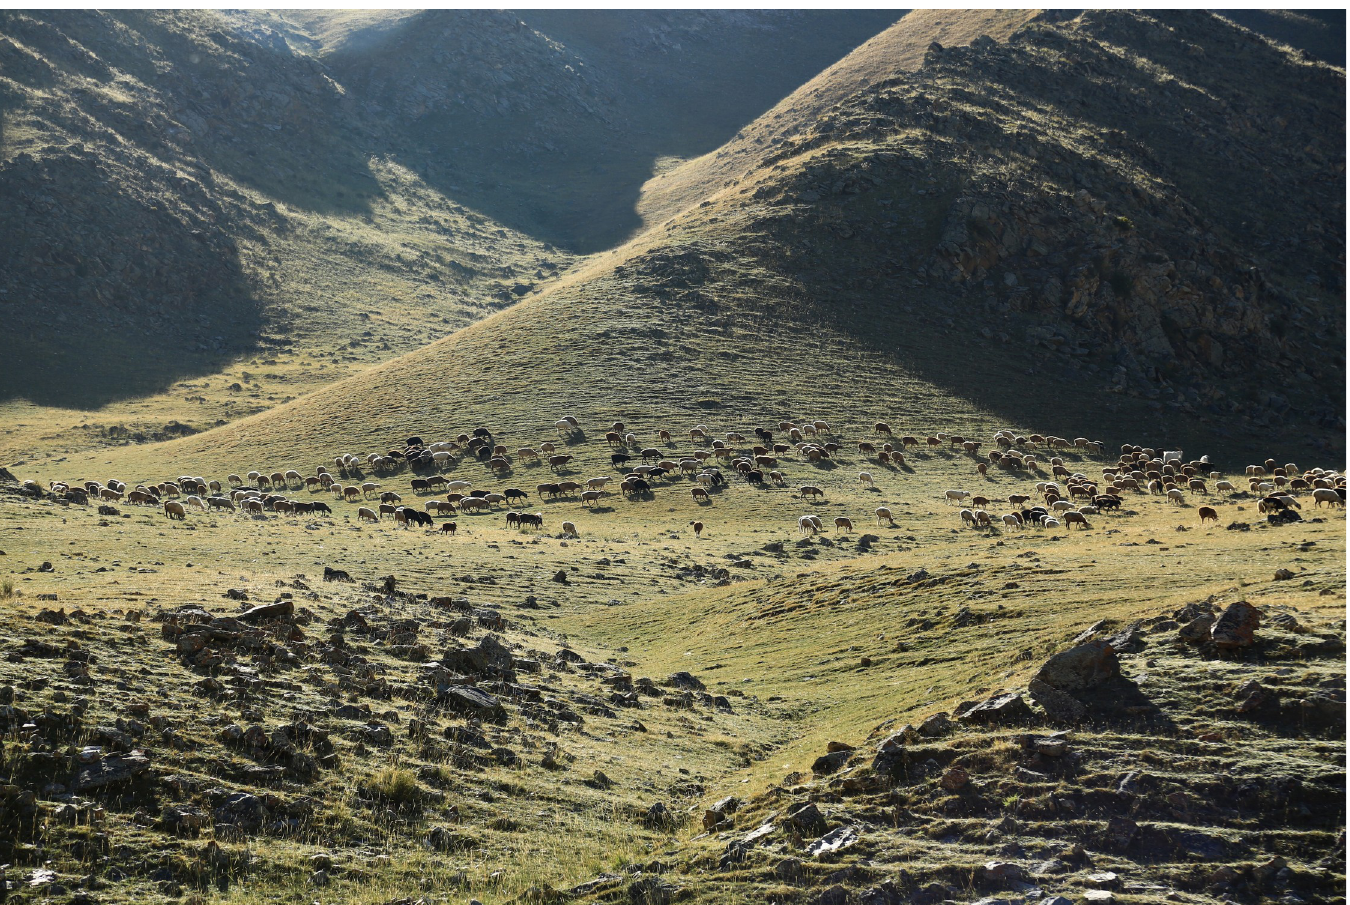
Fig 5. Transhumance from the summer pastures at Harnur to the autumn camp in the river valley in early September 2018 (D. Cong).